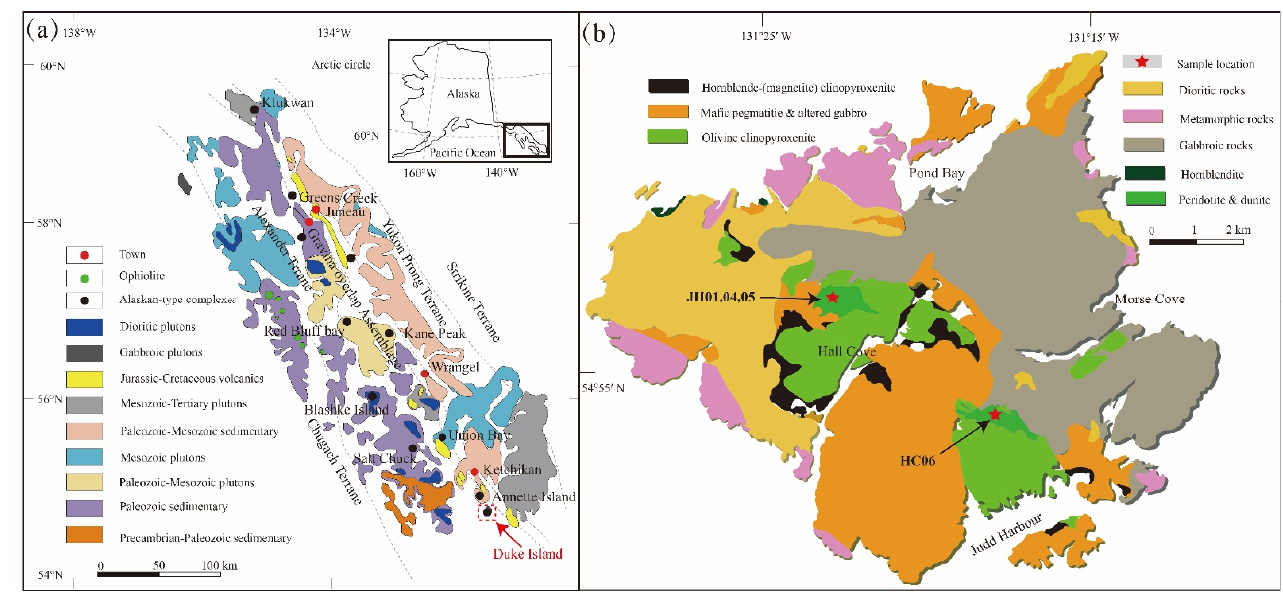
Figure 1. Geological maps of ( a ) southeastern Alaska and ( b ) Duke Island complex (modified after [29]).